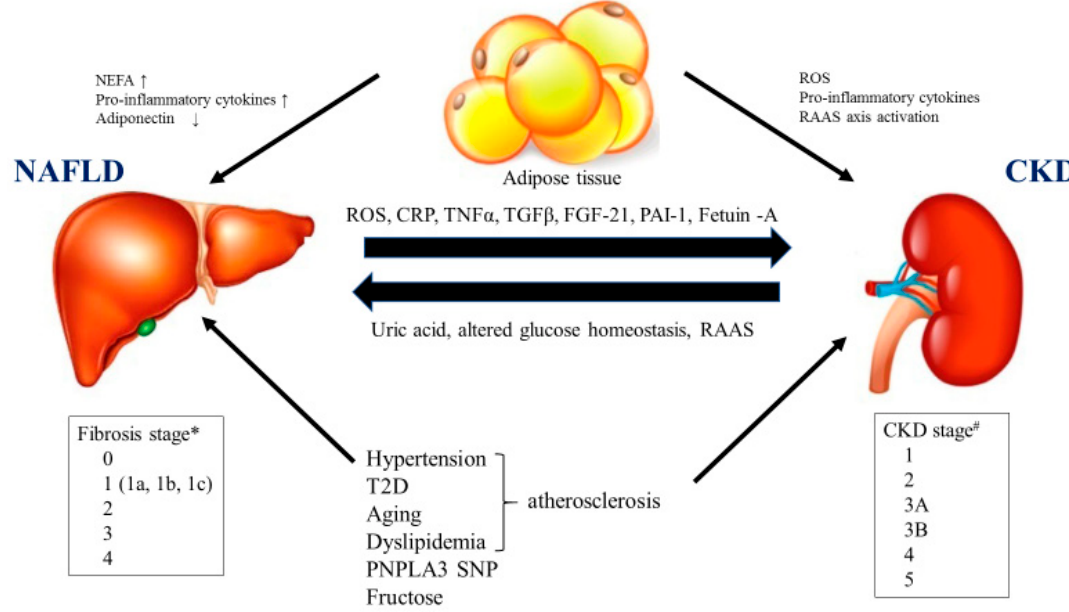
Figure 1. Potential mechanisms linking nonalcoholic steatohepatitis (NASH) / nonalcoholic fatty liver disease (NAFLD) and chronic kidney disease (CKD) / diabetic nephropathy. NEFA: nonesterified fatty acid, ROS: reactive oxygen species, RAAS: renin–angiotensin–aldosterone, CRP: C-reactive